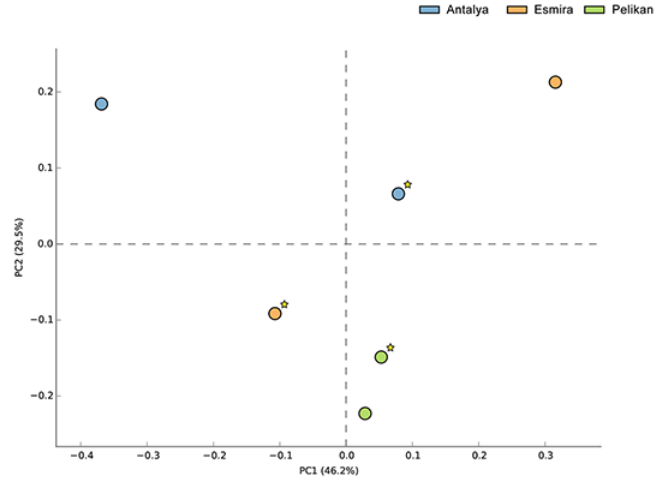
Fig. 2 Principal component analysis of cultivable fungi abundance occurring in tomato cultivars ‘Antalya F 1 ’, ‘Esmira F 1 ’, and ‘Pelikan F 1 ’ after inoculation with mycorrhizal fungus Claroideoglomus etunicatum (asterisk) and without inoculation (without